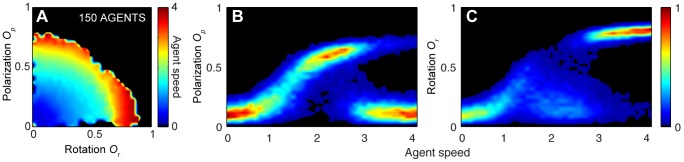
Relationship between agent speed and order in constant-speed agent based simulation model with 150 agents.(A) Density plot of agent speed as function of rotation Or and polarization Op, revealing a bistable regime between the milling and the polar states for high speeds. (B) Normalized probability plot of polarization Op as function of agent speed. (C) Normalized probability plot of rotation Or as function of agent speed. The last two plots illustrate the bifurcation that occurs as the speed is increased, where the system transitions from a swarm state and is found either in a highly polarized state or in a milling state. (See Methods for simulation details).